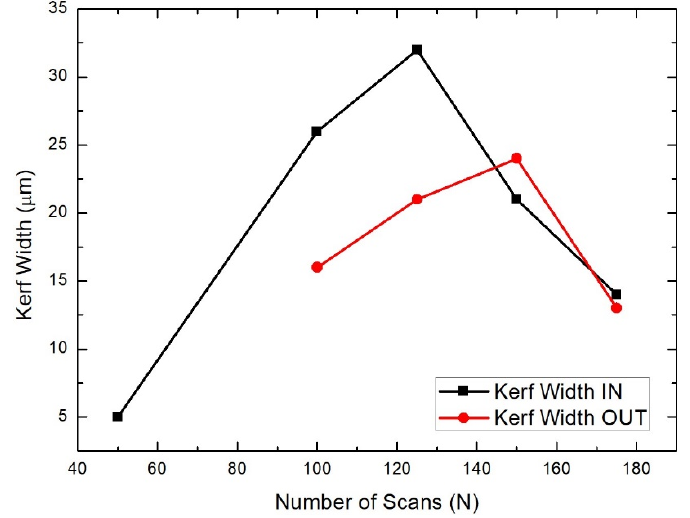
Figure 5. Trend for entry and exit kerfs of linear cuts on cold-worked NiTinol sheet at varying numbers of laser passes.